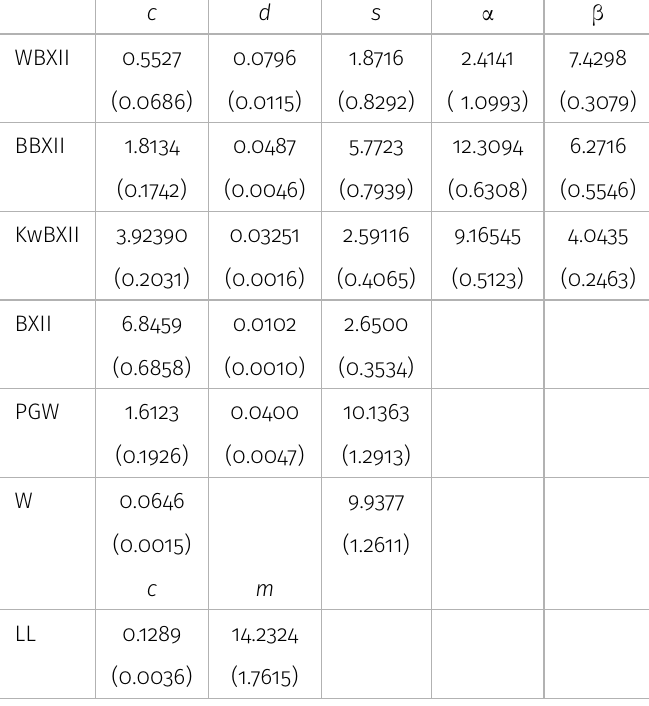
Table IX. MLEs of the model parameters and corresponding standard errors in parentheses. c d